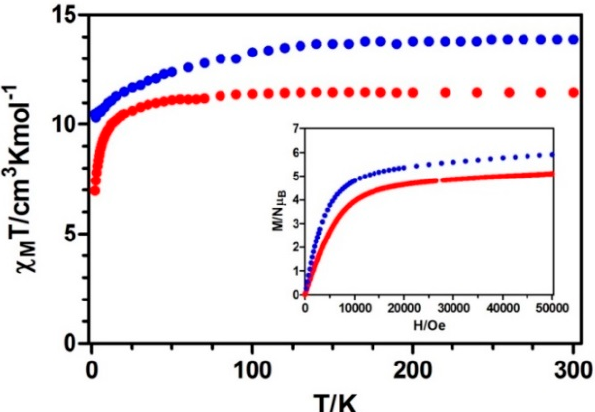
Figure 5. Temperature dependence of the χ M T product at 1000 Oe for 1 and 2 . Inset: M versus H plots for complexes 1 and 2 . Terbium (red) and Dysprosium (blue).